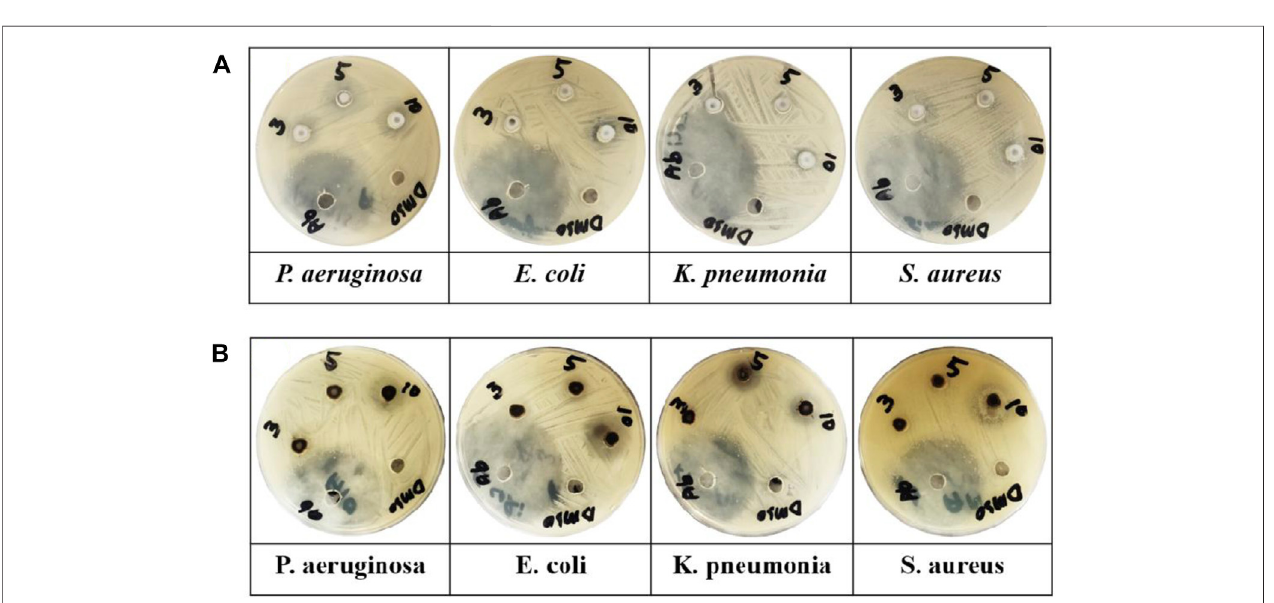
FIGURE 7 | (A) ZnO and (B) B-doped ZnO-NSs applied against various microbe ( P. aeruginosa, K. pneumonia, E. coli , and S. aureus ) in Petri plates.